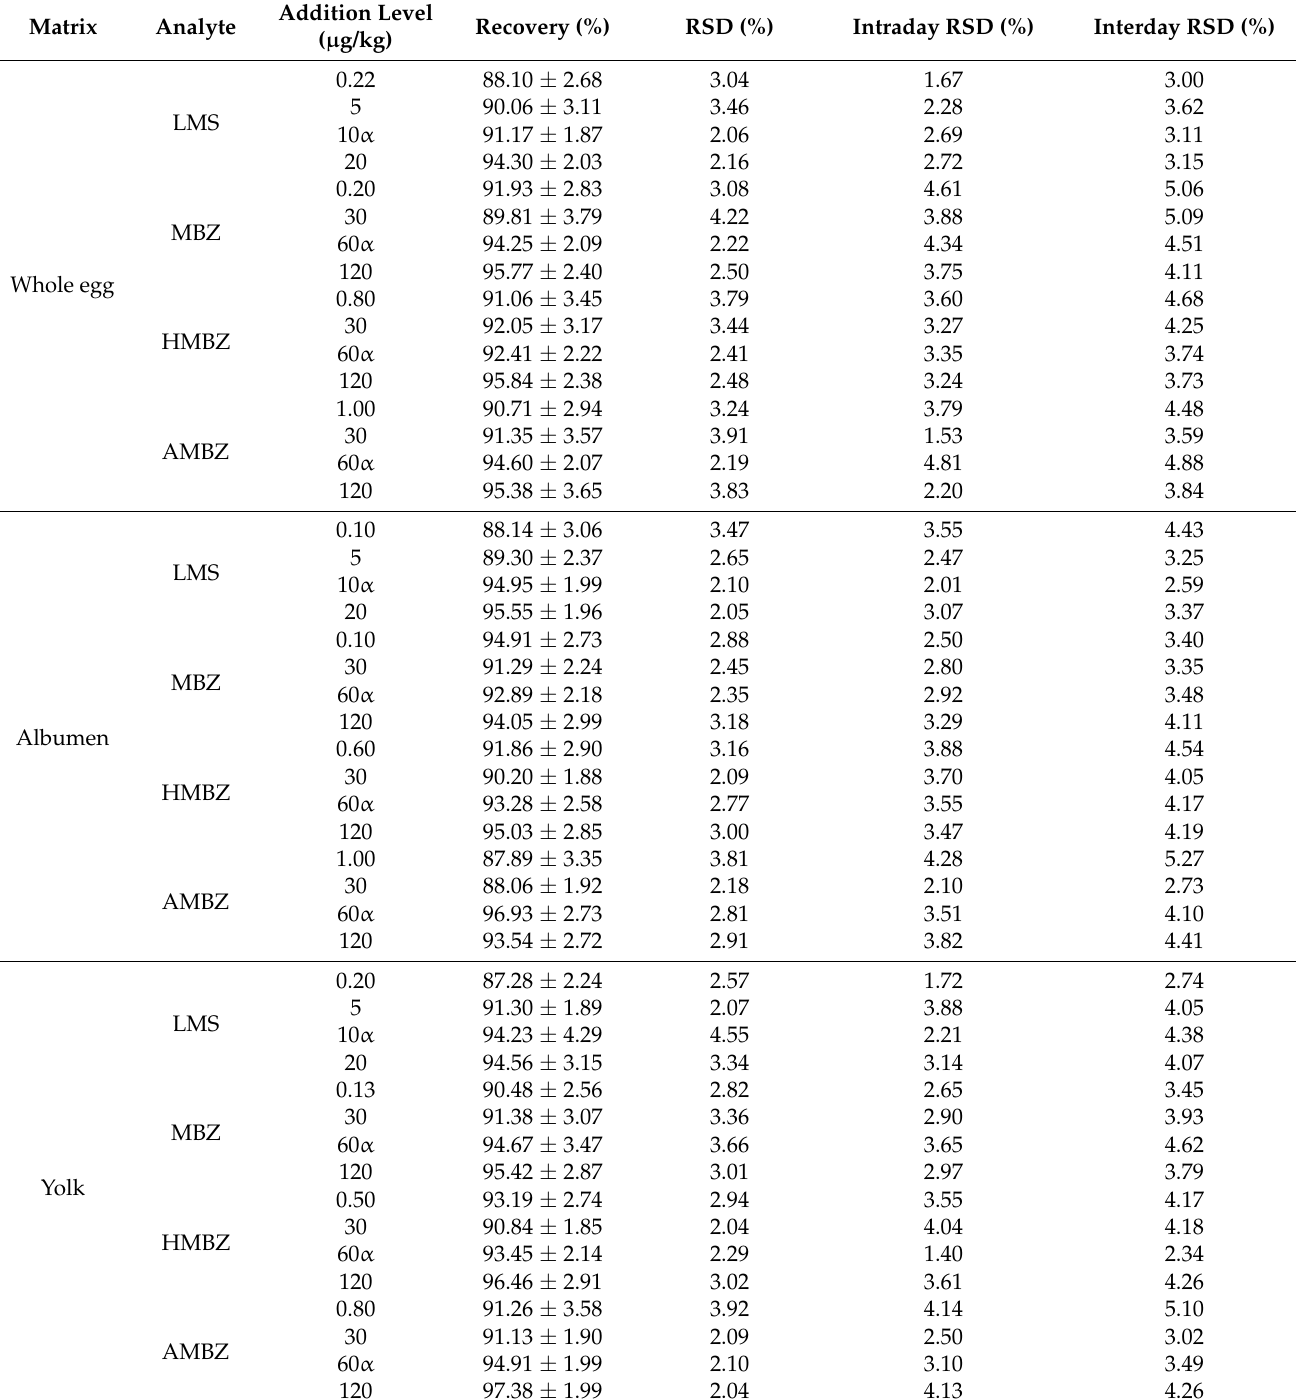
Table 5. Recovery and precision of LMS, MBZ, HMBZ, and AMBZ added to blank hen eggs ( n =